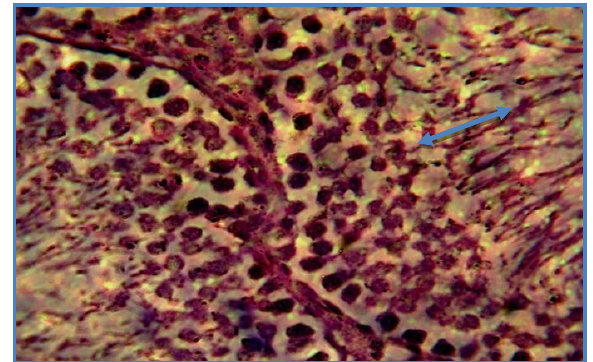
Figure, 4: Cross section of the rat testes of group T2 showing complete spermatogenesis with presence large number of sperm in the lumen of seminiferous tubules (H and E stain